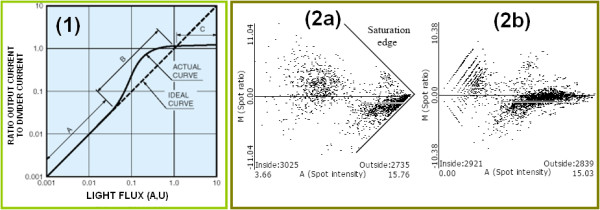
Double-Scan procedure. In (1) the transfer function of the photo detectors used in the scanners is depicted. At high intensities the relationship between the incident light level and the output current begins to deviate from the ideal intensity in an effect called saturation that is typically drawn in an arrow shape (see 2a). On the other hand, quantization occurs when digitizing. All the unlimited physical values have to be encoded by a reduced set of discrete values, producing the same rate for a range of different values [21]. This effect can be observed in (2b) as a set of parallel lines. 2-Scan strategy [16] is based on the rather simple idea of producing two images with different calibrations, from which a mathematical model produces a coherent but extended range of values.